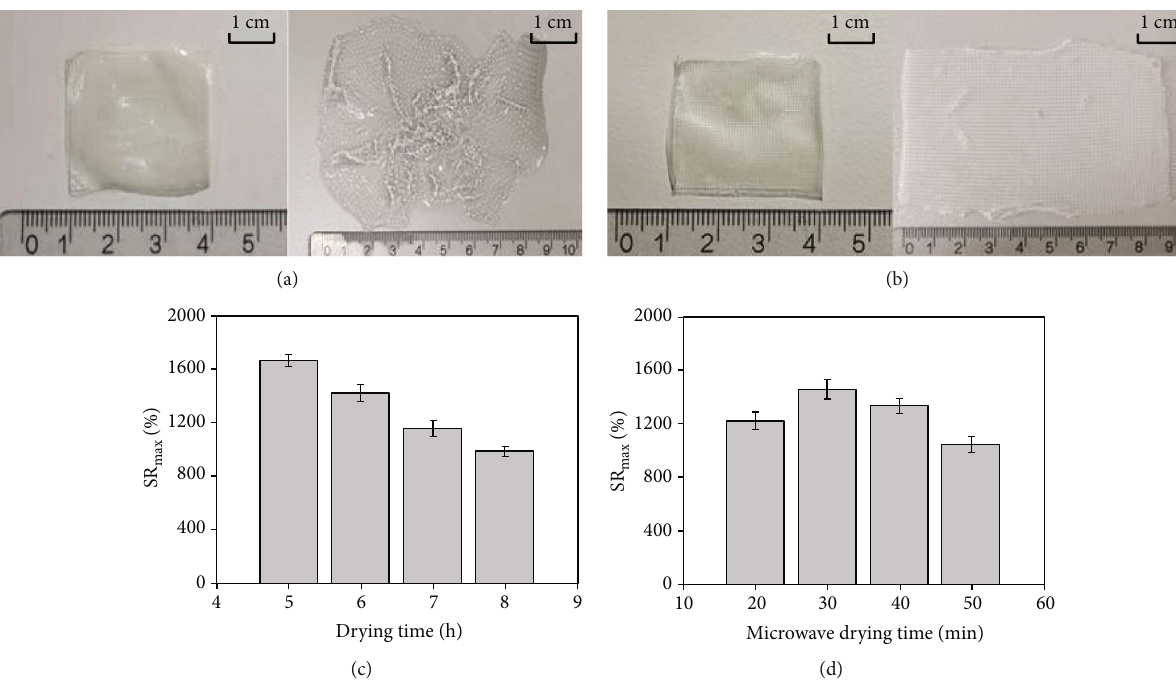
Figure 8: Swelling graphs of hydrogel-crosslinked microneedles without microwave assistance (a) and with microwave assistance (b) under the same drying time. The maximum swelling histogram at di ff erent drying times (c) for the hydrogel-crosslinked microneedles dried using a conventional oven. The maximum swelling histogram of the hydrogel-crosslinked microneedles dried using microwave-assisted drying at di ff erent drying times (d). The error line represents the standard deviation of the swelling e ff ect of repeated determination of 10 groups of independent samples ( n = 10 ). The histogram shows the average